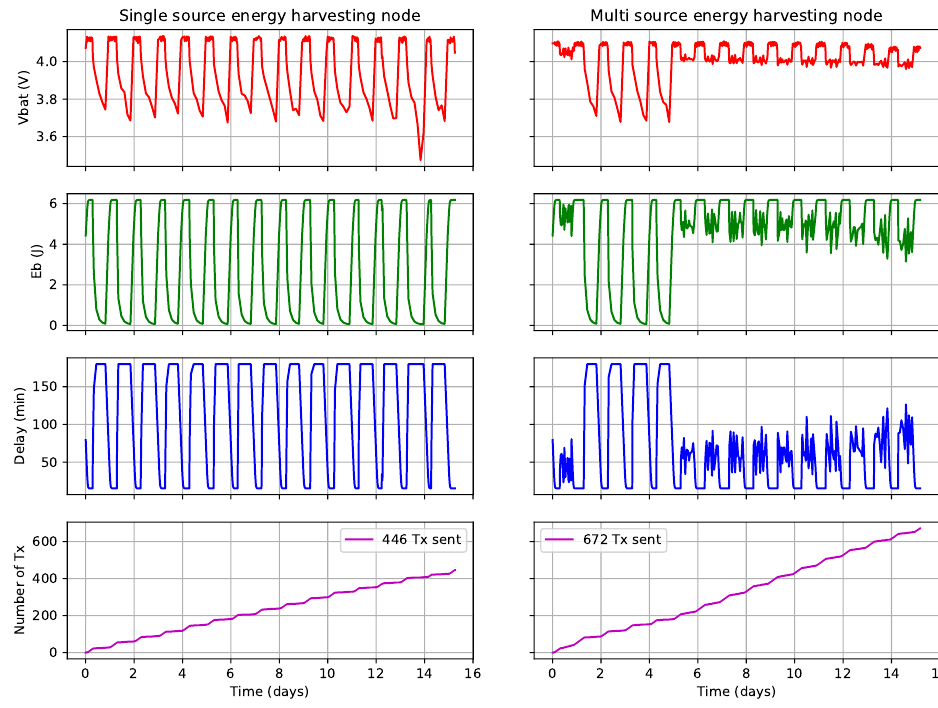
Figure 4. Experimental measurement of single and multi- source energy harvesting systems. The experiment was run for a total of 15 days. The emulated TEG was turned off during the second day in order to test the efficiency of multi-source energy harvesting with similar types of energy sources, i.e., two solar panels. The emulated TEG was turned on at the end of the fifth